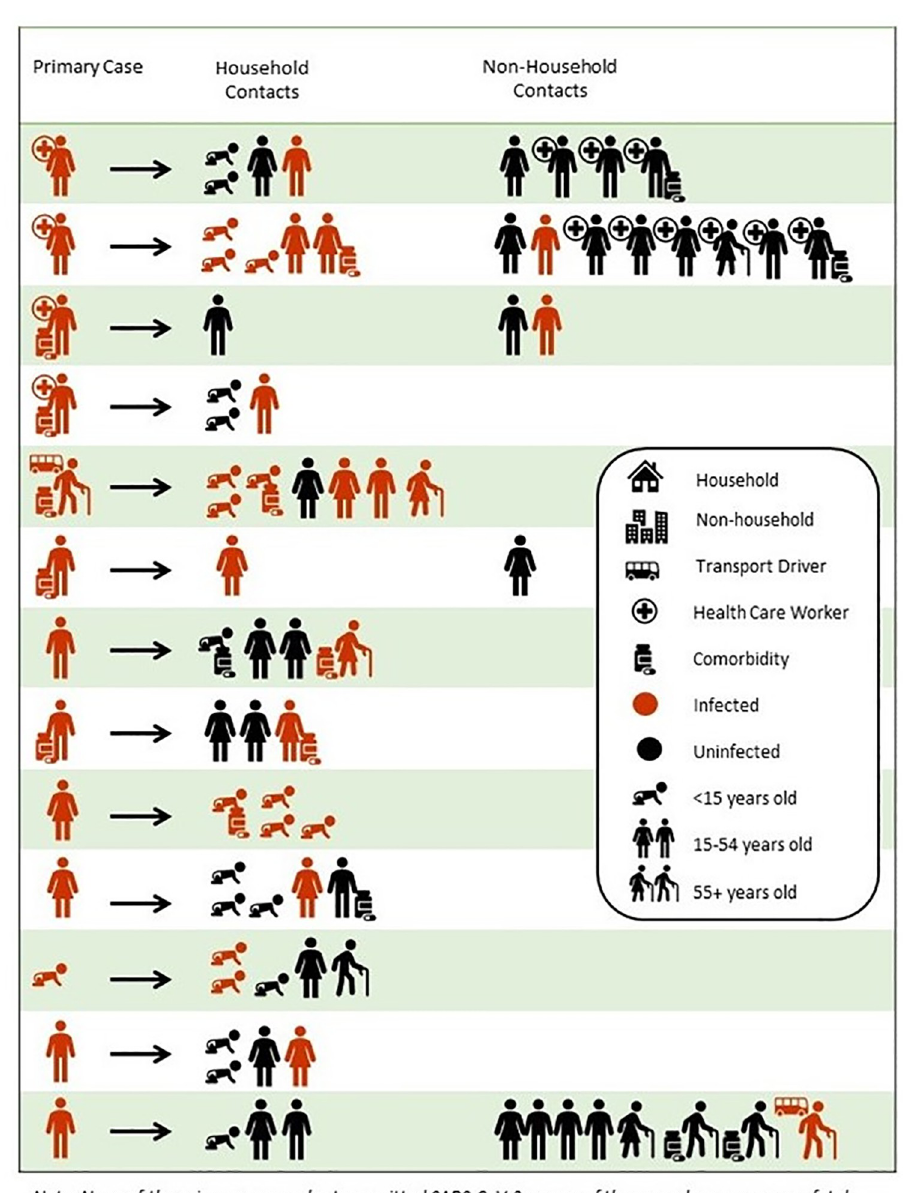
Fig 4. Visual Representation of Secondary Transmission, FFX Study, Kisumu, Kenya, June-October 2020.